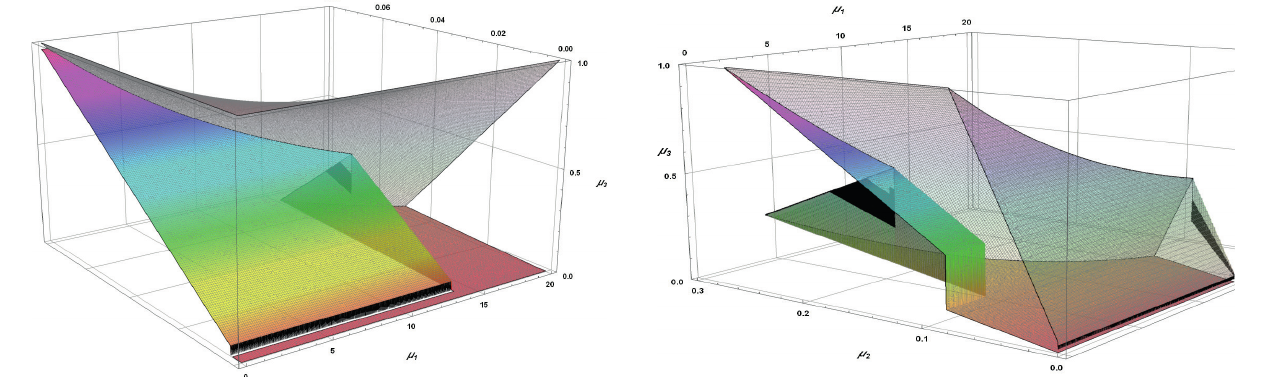
Figure 7 Partial definition area for subset A